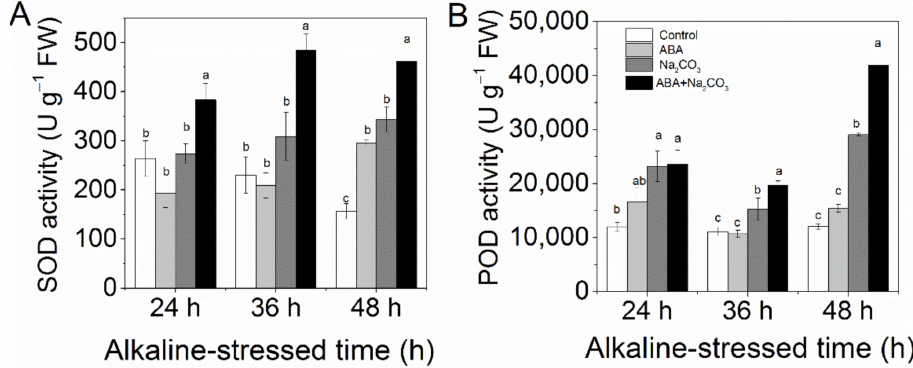
Figure 3. Abscisic acid (ABA) priming increased the activity of antioxidant enzymes and upregulated the expression of ROS-scavenging genes in alfalfa ( Medicago sativa L.) seedlings under alkaline stress. Eighteen-day-old alfalfa seedlings were root-drenched with 10 µ M ABA or without ABA (Control) for 16 h and then exposed to unstressed (Control and ABA) or alkaline-stressed (Na 2 CO 3 and ABA + Na 2 CO 3 , 15 mM Na 2 CO 3 ) conditions. The activities of ( A ) superoxide dismutase (SOD) and ( B ) and peroxidase (POD) enzymes were measured at 24 h, 36 h, and 48 h of alkaline treatment. Values are the mean ± standard error, n = 3. Different letters on the columns indicate significant differences ( p < 0.05) at each time point based on Duncan’s